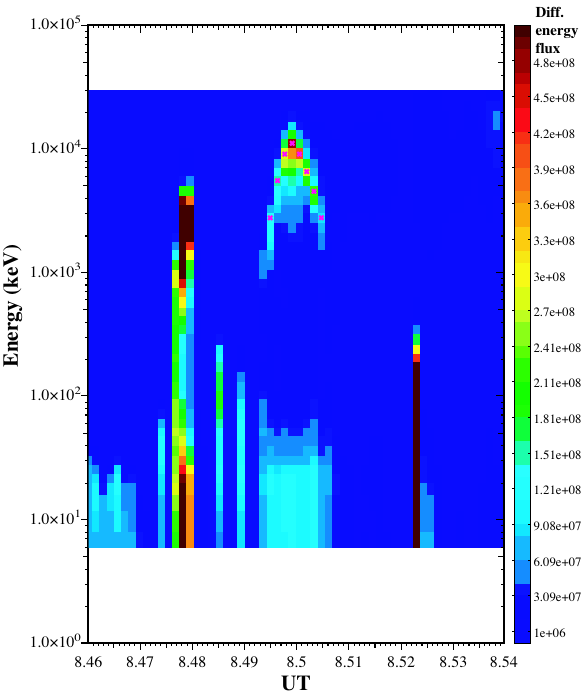
Fig. 2. Energy–distance curve of the best 97 events on the top of each other. One of these curves comes from the pink spots in Fig- ure 1. The thickest line is an arithmetic average of all curves, i.e. an average shape of the inverted-V’s as seen in the electron data. No scaling has been done for these data.